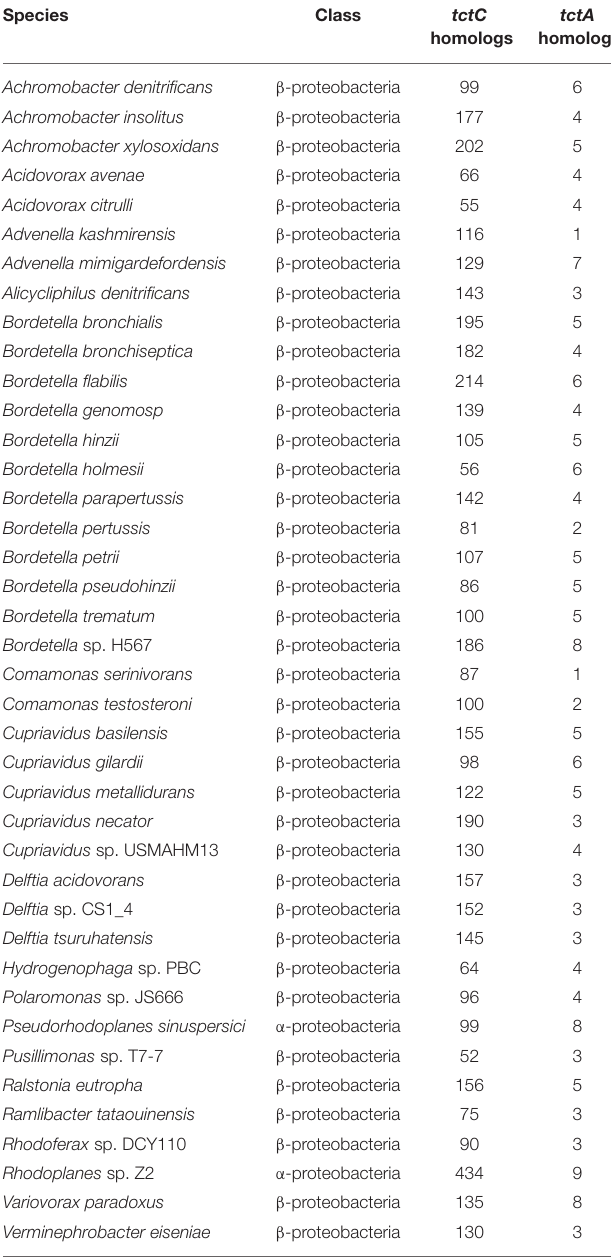
TABLE 3 | Number of TctC and TctA homologs per